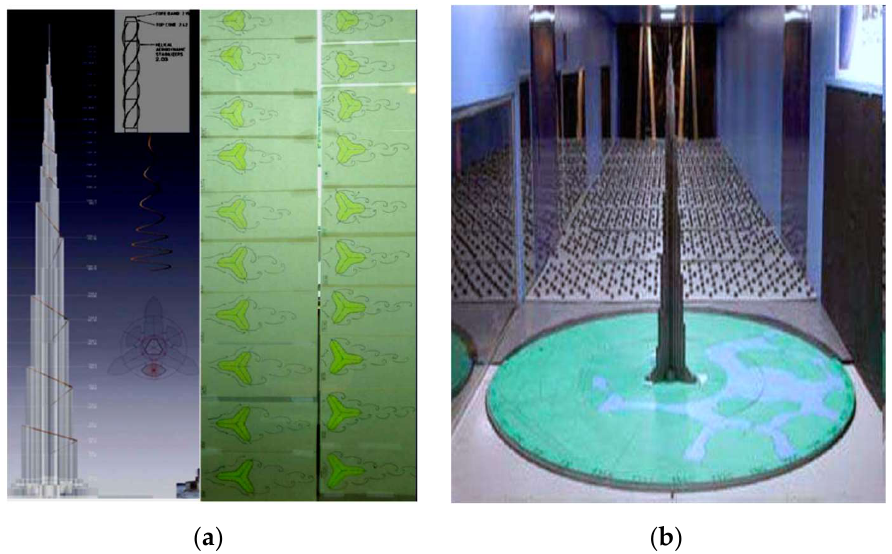
Figure 11. ( a ) Vortex shedding formation, with different, ( b ) aero elastic wind tunnel model at Guelph resonance frequencies, along the building height. Source: [6].